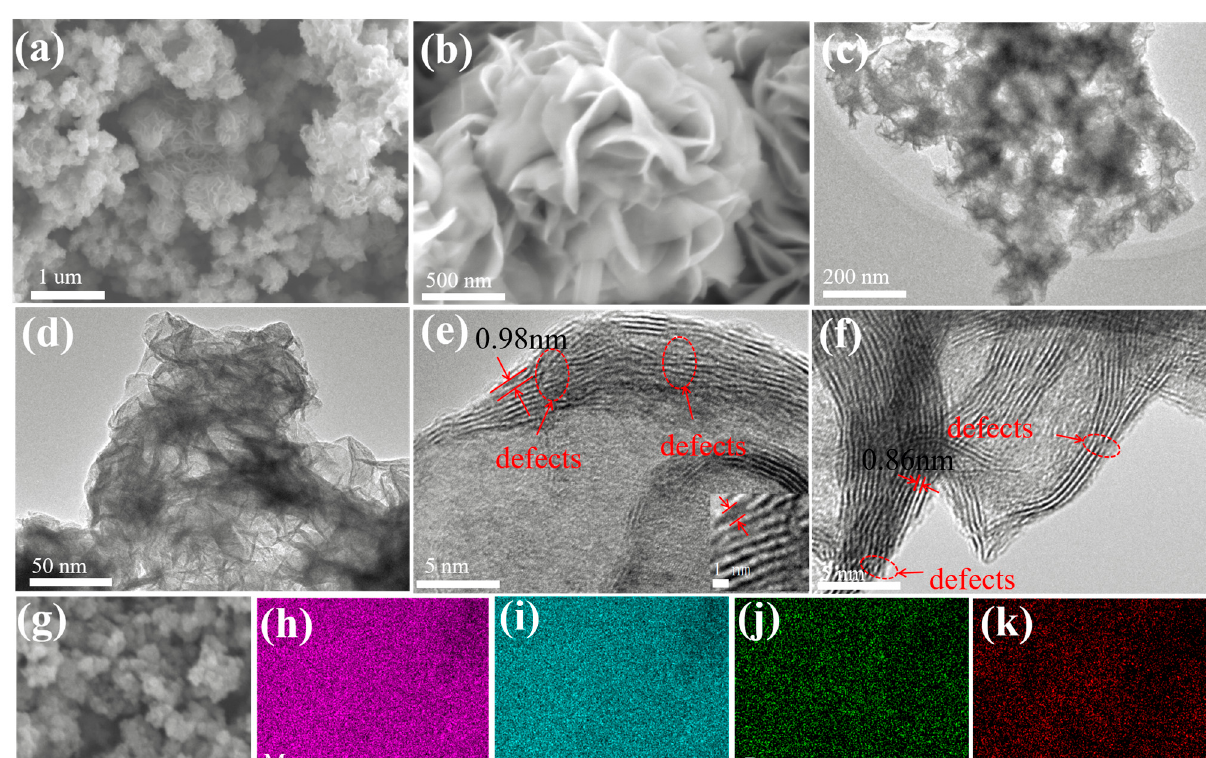
Figure 2. ( a , b ) SEM; ( c , d ) TEM; ( e , f ) HRTEM; ( g – k ) EDS of P-MoS 2.